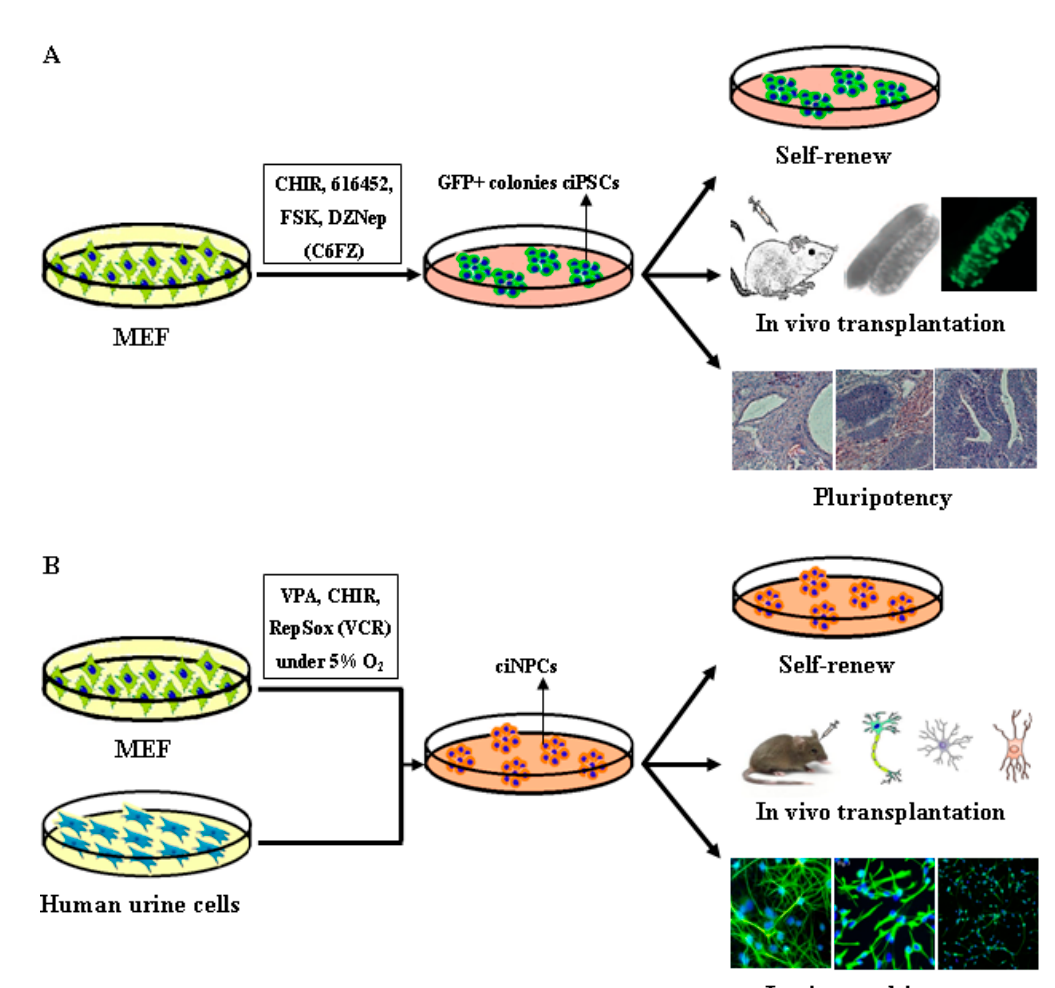
Figure 4. Chemical-based reprogramming to chemically induced pluripotent stem cells (ciPSCs) and chemically induced neural stem cells (ciNSCs): ( A ) Schematics of direct iPSC transdifferentiation from mouse embryonic fibroblasts (MEF) using seven small-molecule cocktail leading to GFP-Oct4 expressing ciPSCs generation. After in vivo transplantation, the ciPSCs can differentiate into cells of all three germ layers. After screening, the four small molecules, C6FZ (CHIR99021, 616542, Forskolin and DZNep) were found to be critical in inducing CiPSCs [17]; ( B ) direct ciNSC reprogramming from MEFs and human urinary cells using a three small-molecule cocktail VPA, CHIR99021, and Repsox (VCR) under hypoxic condition (5% O 2 ) [13].